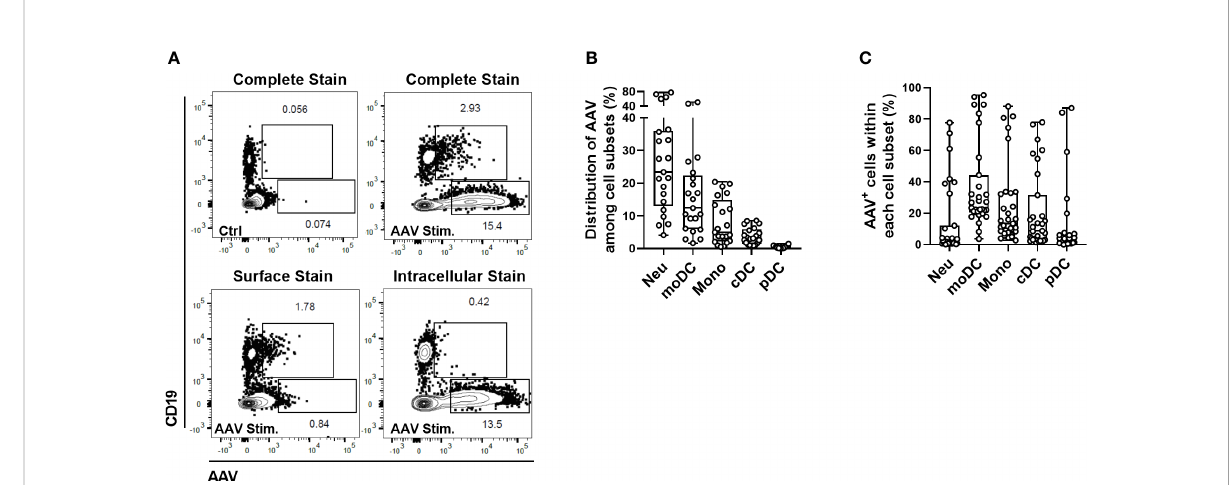
FIGURE 1 Identi fi cation of cellular subsets in human blood able to internalize AAV vector. Blood cells were stimulated with 5×10 11 vg/mL of AAV-LK03 for 24 hours. (A) Representative FACS plots that show intracellular localization of AAV particles in CD19 - cells and surface localization on the CD19 + cells. (B) Distribution of AAV + cells among blood cell types. (C) Percent of AAV + cells within each cellular